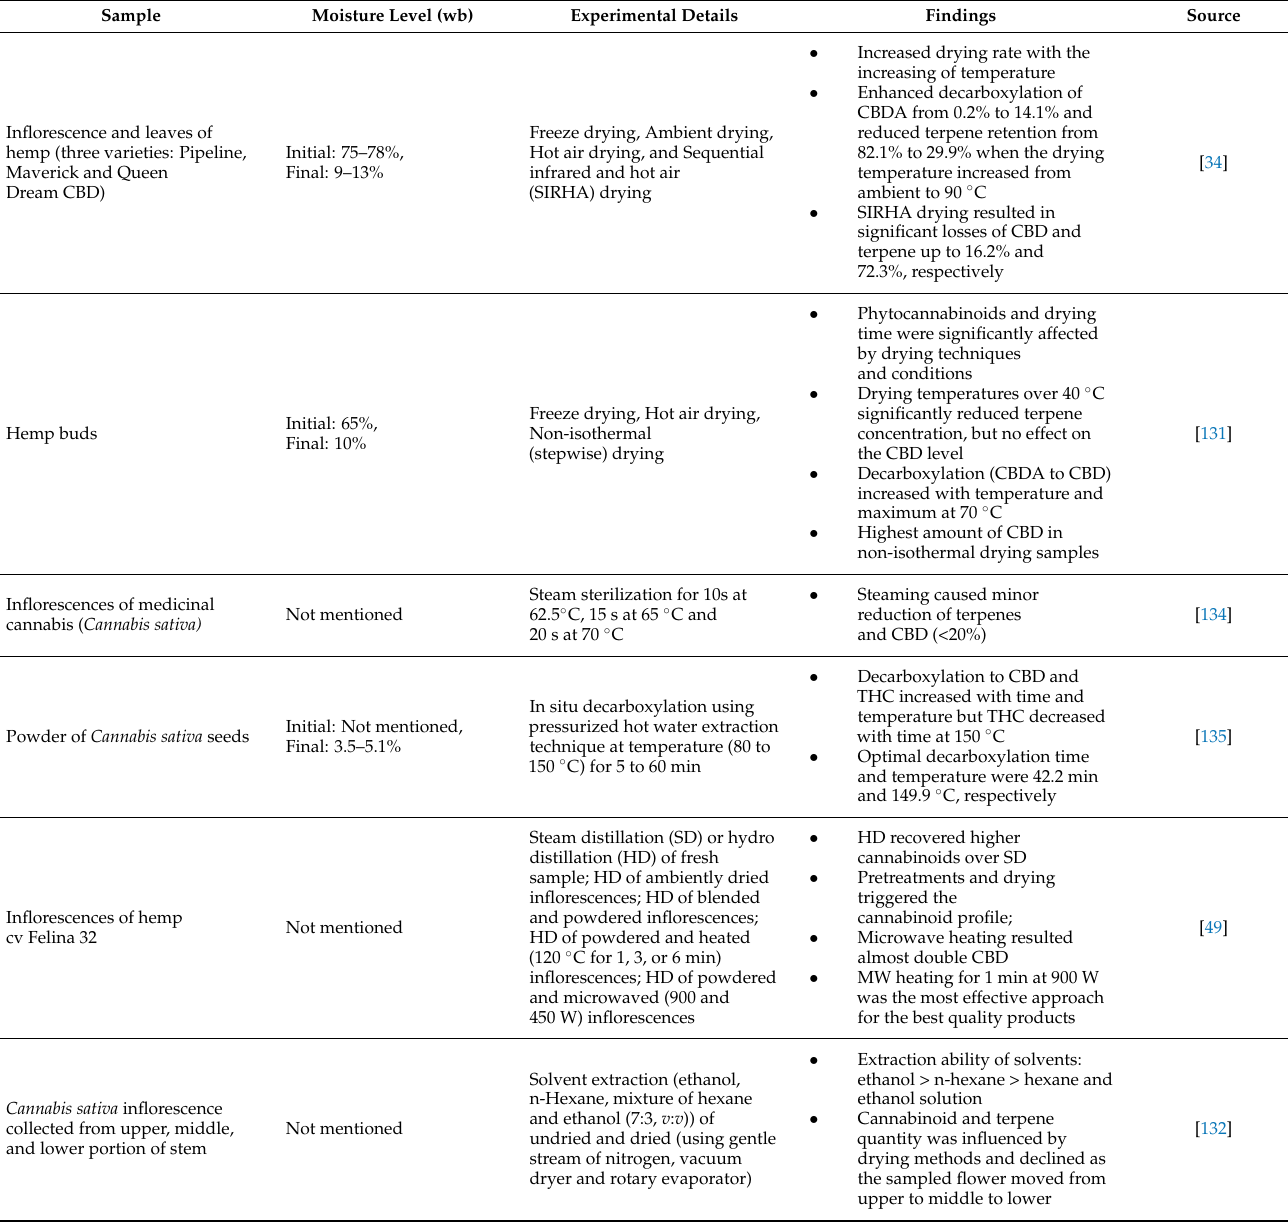
Table 1. The effect of postharvest treatments on the cannabinoid profile of